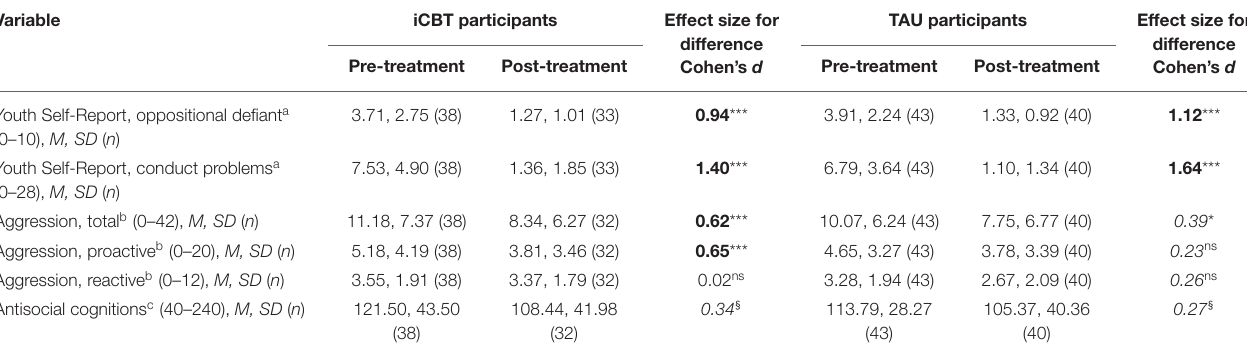
TABLE 2 | Pre- to post-treatment comparisons (within-group) of self-reported conduct problems, aggression, and antisocial cognitions in an RCT of an individualized CBT intervention (iCBT) plus treatment-as-usual (TAU) vs. TAU-only among serious, young male violent offenders. Variable iCBT participants